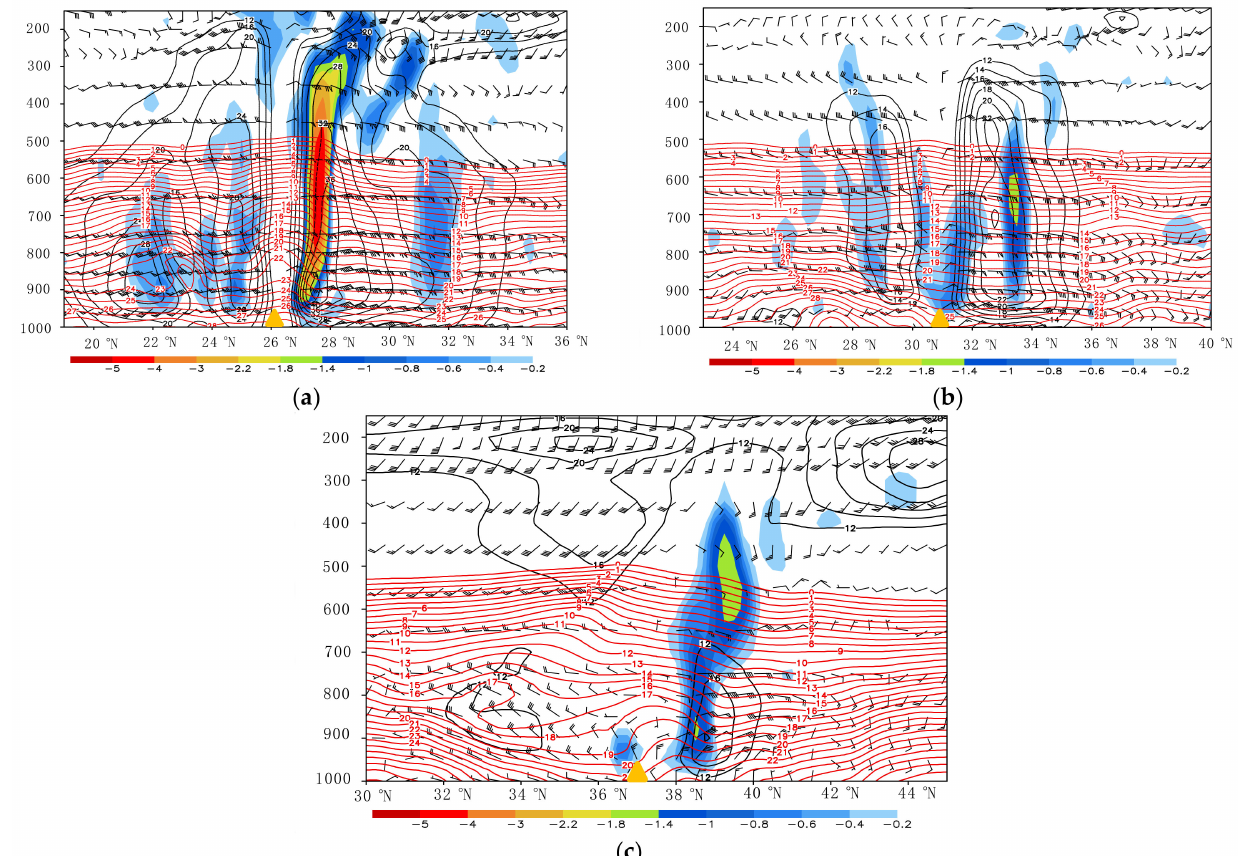
Figure 7. Vertical cross-section of horizontal wind (wind barb), wind speed (black contour, unit: m s − 1 ), temperature (red contour, unit: ◦ C), and vertical velocity (shaded, unit: Pa s − 1 ) at ( a ) 0800 BT on 24 July 2021, along 124.5 ◦ E. (left column); ( b ) 2000 BT on 26 July 2021, along 120 ◦ E, and ( c ) 2000 BT on 29 July 2021, along 117 ◦ E. The orange triangle indicates the location of TC